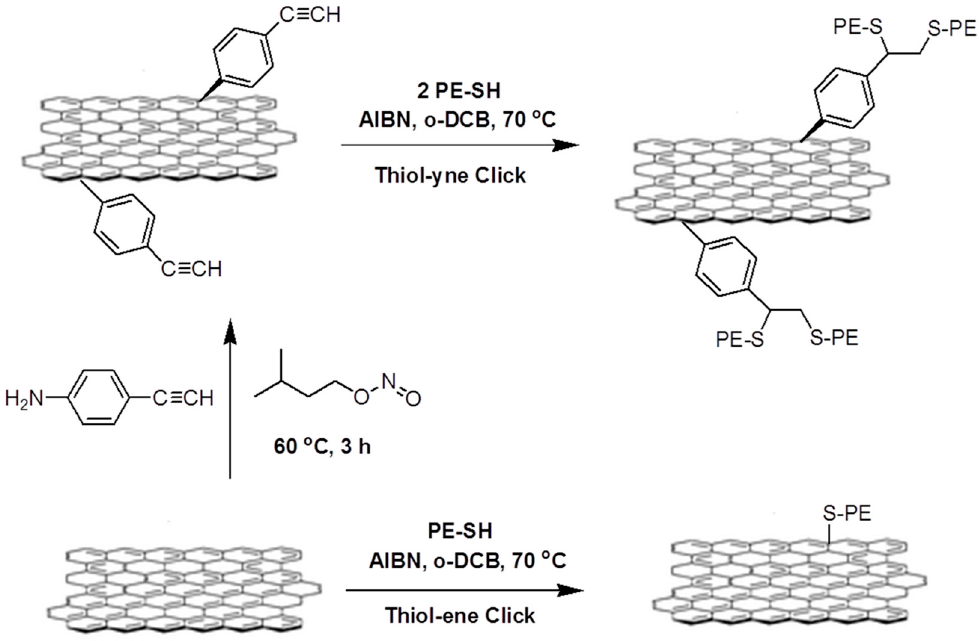
Figure 8. Thiol-ene- and thiol-yne-mediated polymer grafting from graphene surface. Adapted with permission from [170]. Copyright © 2013 by The Royal Society of Chemistry.